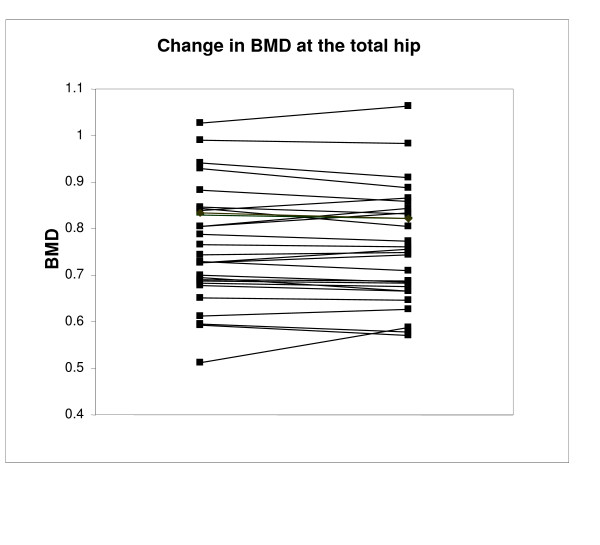
Changes in BMD at the hip following discontinuation of bisphosphonates for 12–18 months after long-term use.